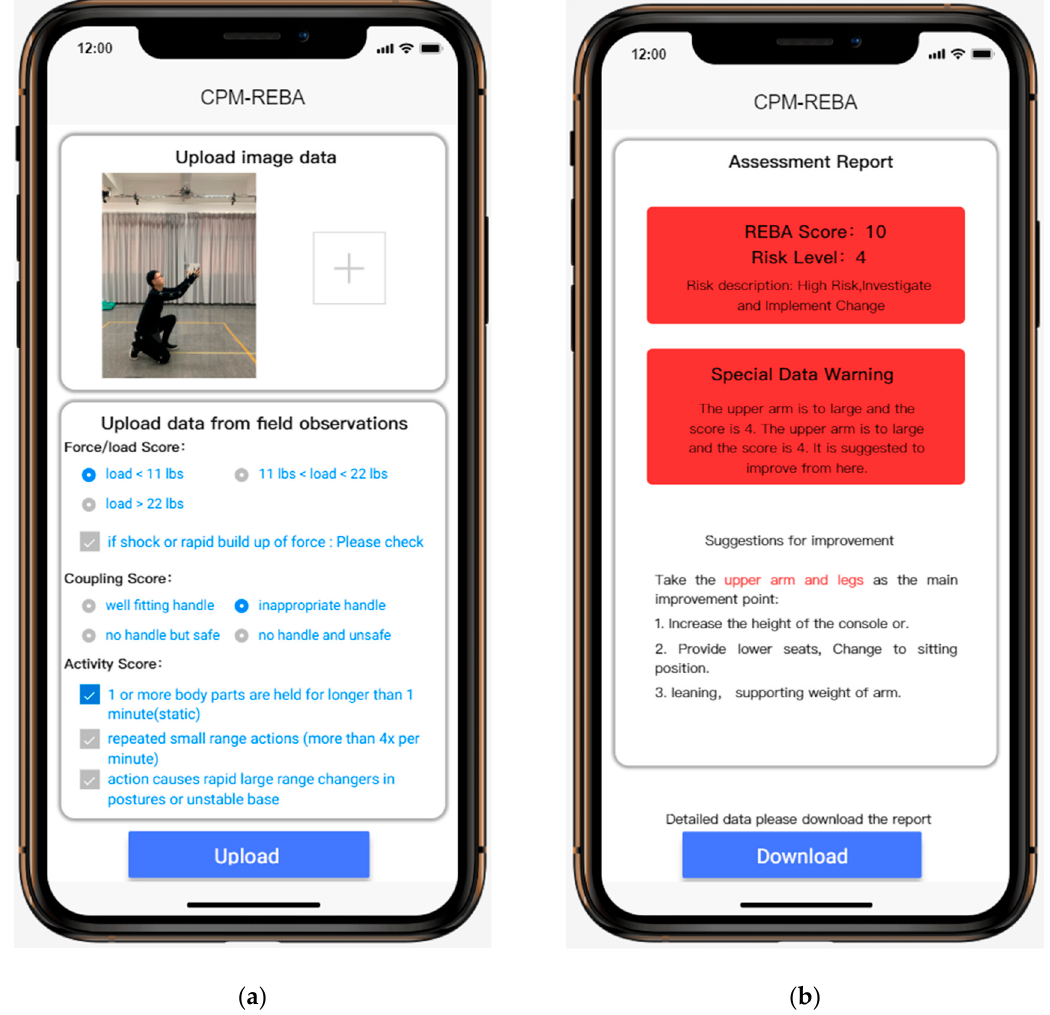
Figure A1. The main interface of the Quick Capture system. Data collection and upload ( a ), and REBA online assessment report ( b ).